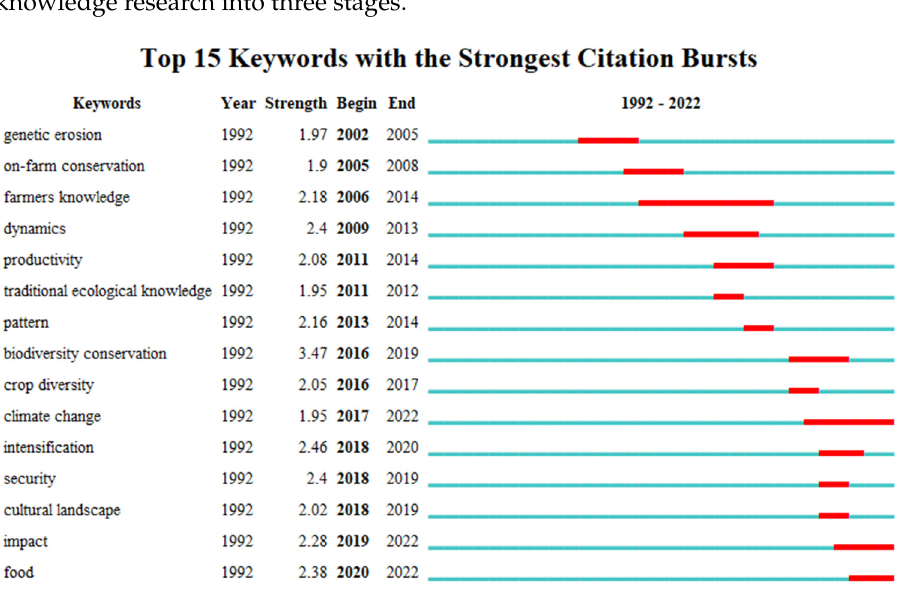
Figure 7. Top 15 keywords with the strongest citation bursts of agrobiodiversity and traditional knowledge from 1992 to mid-2022.